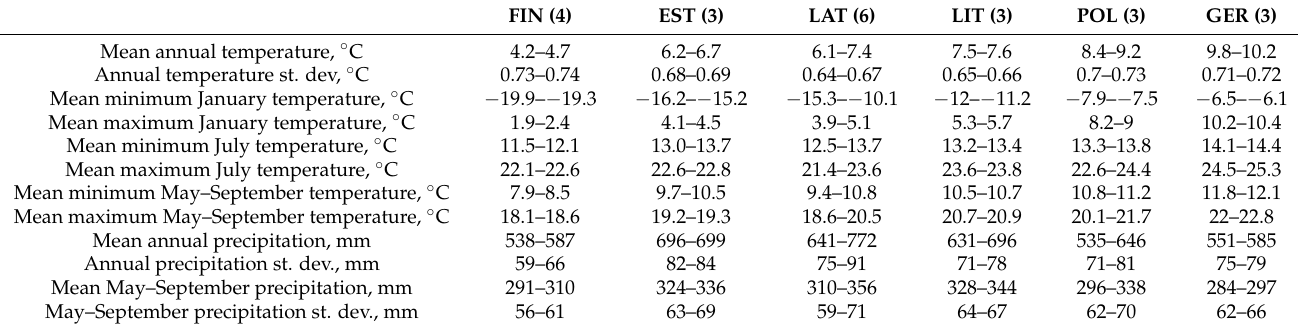
Table 2. Climatic description of the studied sites by country (the ranges are given). Data represent the 1989–2018 period. January and July are the coldest and warmest months, respectively. The May–September period generally corresponds to the vegetation period. Number in brackets indicate number of sampling sites. St. dev.—standard